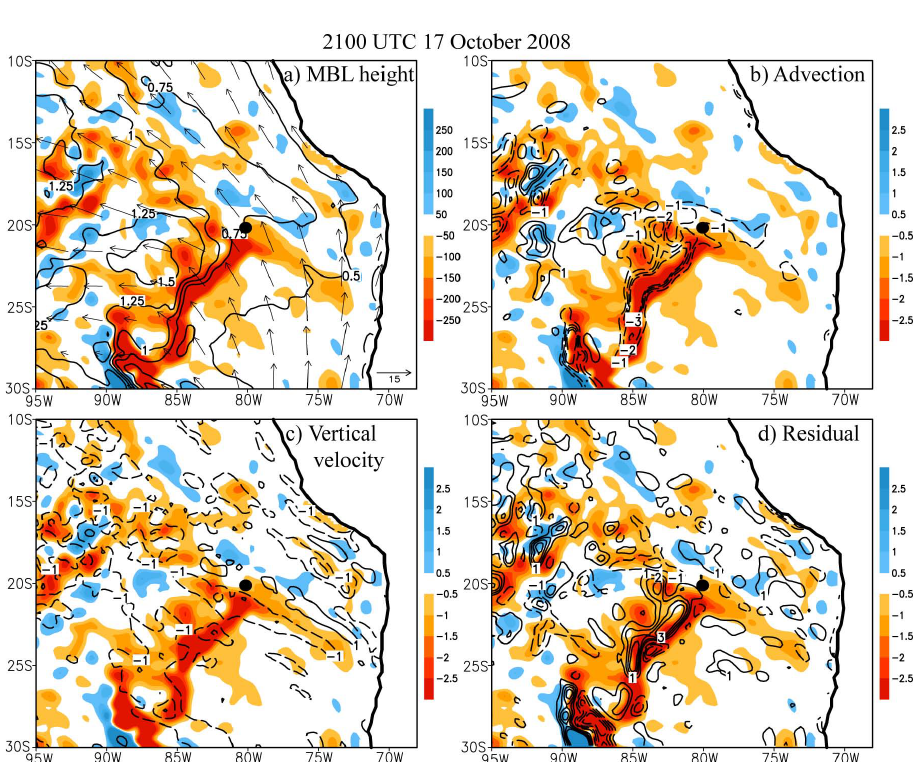
Fig. 11. As Fig. 10, but for 21:00UTC 15 October.